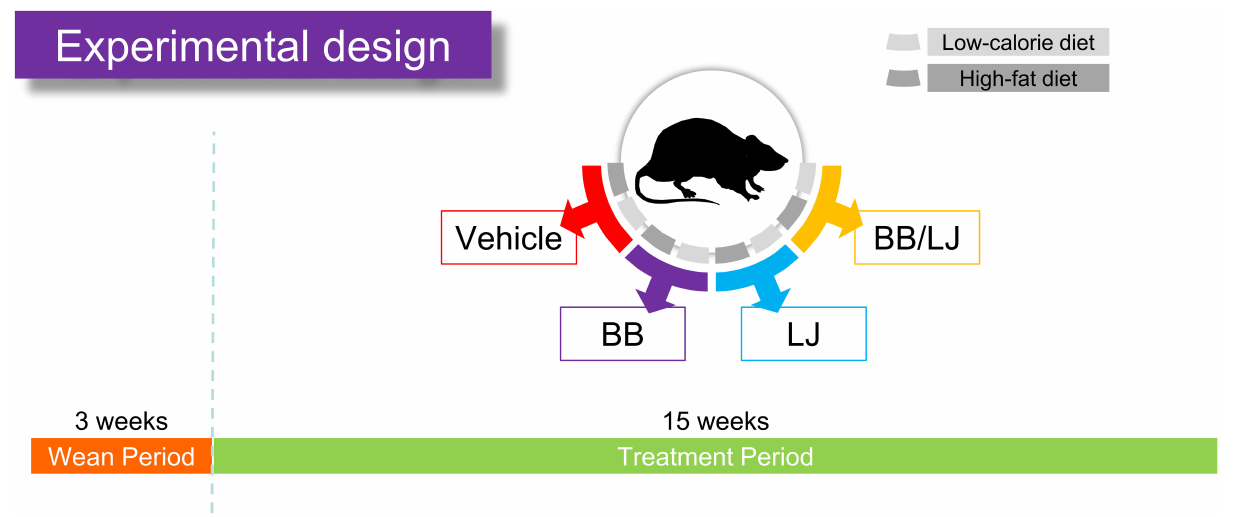
FIGURE 1 | Feeding assay design. After pregnant females gave birth and pups were weaned after 3 weeks, the rats were separated into two diet groups (HF and LC diet), in which diet groups were subdivided into four treatment groups (vehicle control, BB, blueberry extract; LJ, L. johnsonii N6.2; BB/LJ, blueberry extract + L. johnsonii N6.2). Animals were fed ad libitum for 15 weeks and were treated three times a week.